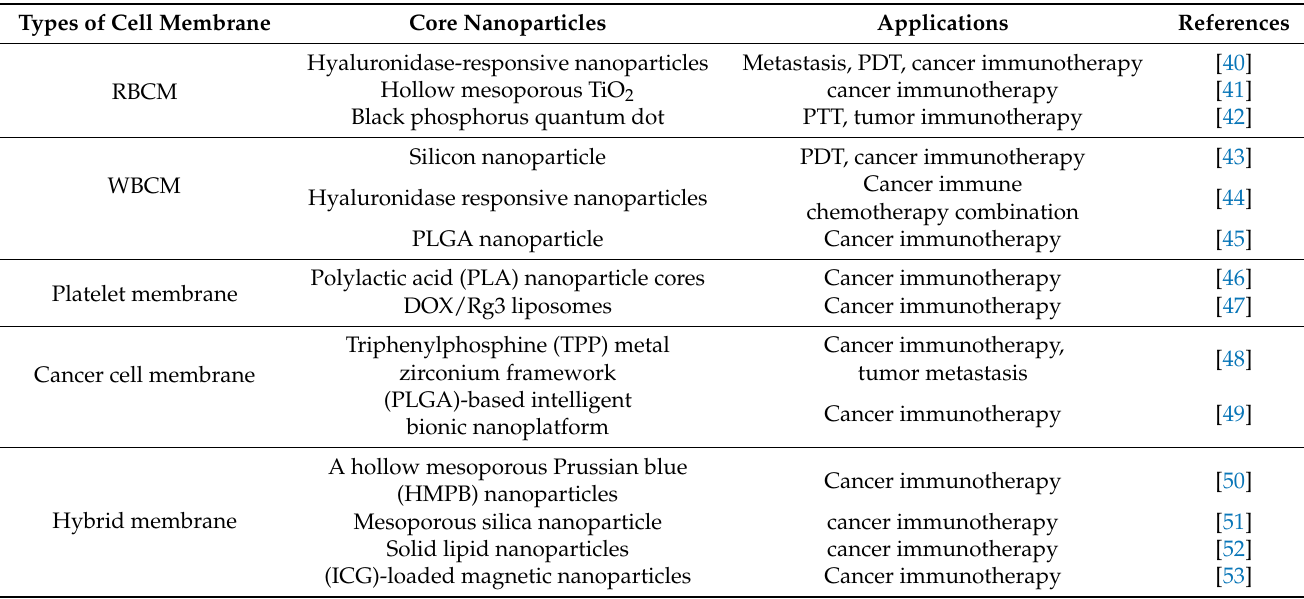
Table 1. A summary of the cell membrane-coated